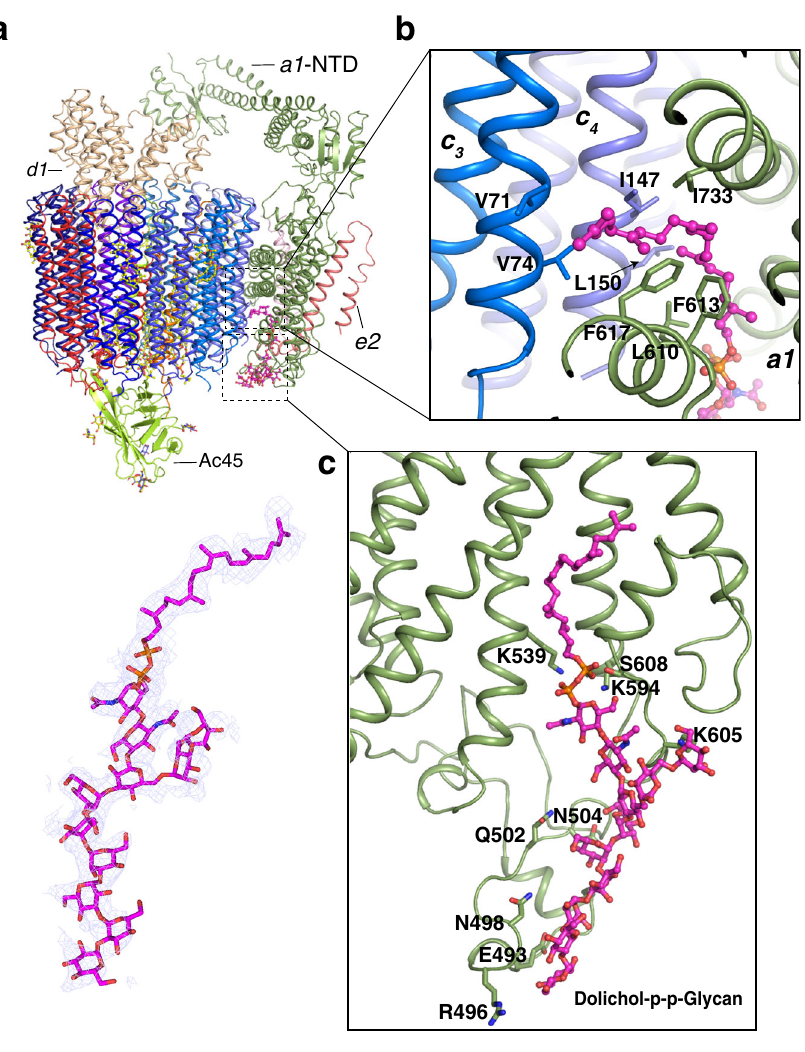
Fig. 2 Interaction details between V o domain and glycolipid dolichol phosphate-linked glycan (Dolichol-p-p-Glycan). a Overall structure showing the position of Dolichol-p-p-Glycan in Vo domain. The cryo-EM map of Dolichol-p-p-Glycan as blue mesh is shown at 3.5 σ level (lower panel). b The interaction details of Dolichol-p-p-Glycan chain with the a -CTD, c 3 and c 4 subunits. c The interaction details of sugar moiety of Dolichol-p-p-Glycan with the a -CTD. The Dolichol-p-p-Glycan is colored in magenta and the residues are shown in